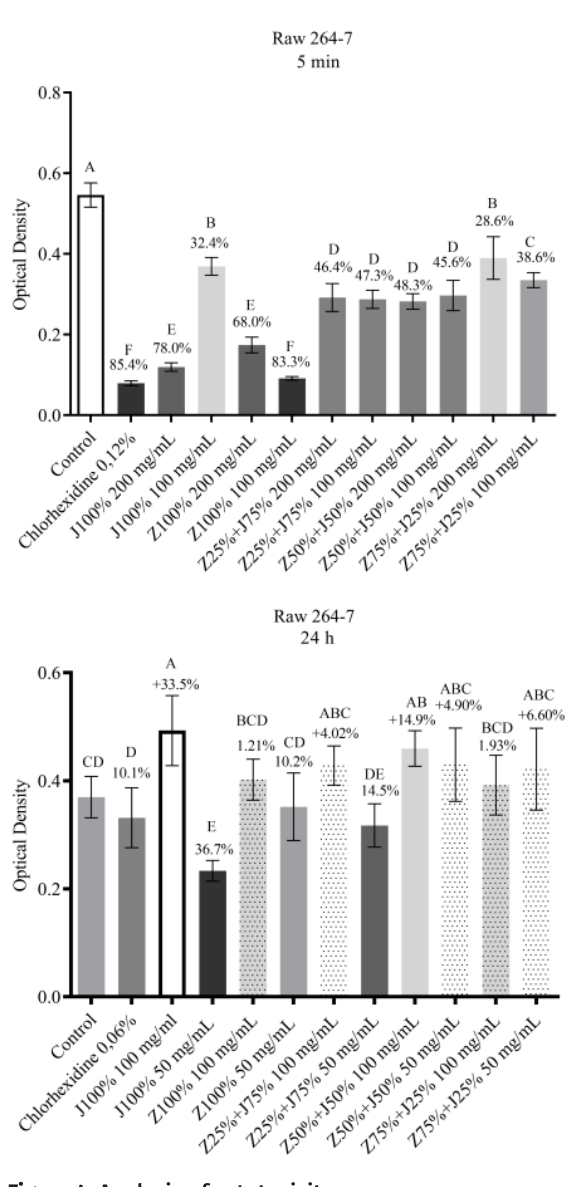
Figure 4. Analysis of cytotoxicity on mouse macrophages (RAW264.7) by MTT